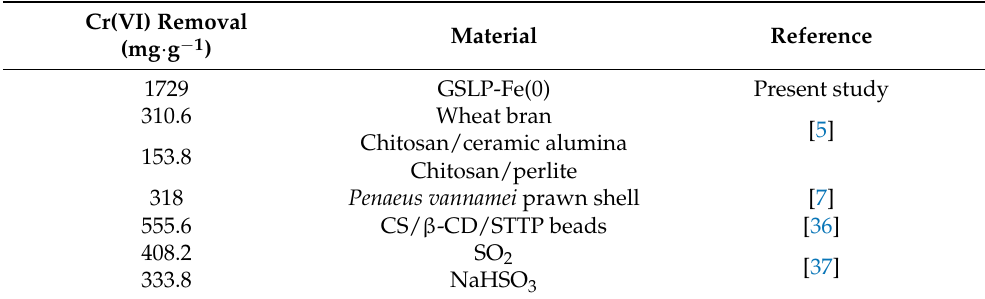
Table 4. Comparison of Cr(VI) removal by GSLP-Fe(0) with other materials and typical Cr(VI) removers in